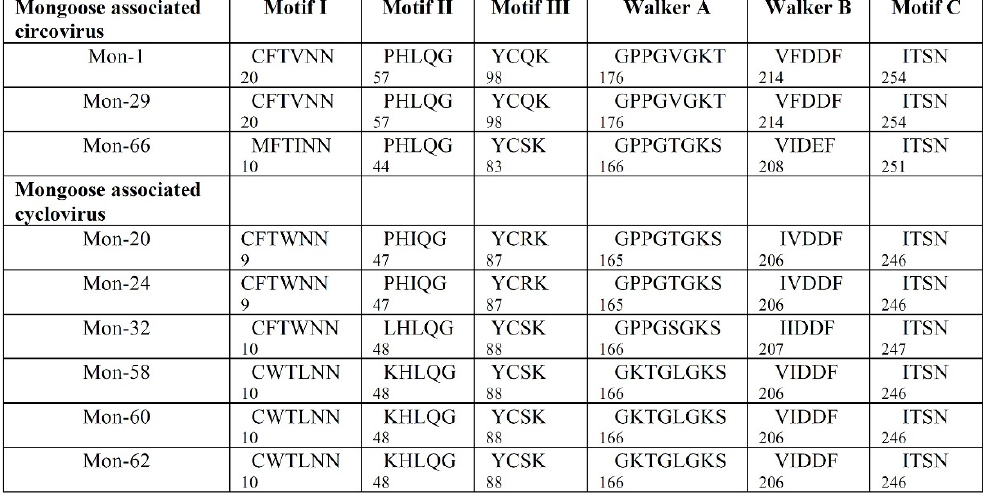
Figure 4. Presence of the conserved rolling circle replication (motifs I through III) and superfamily 3 helicase (Walker A and B, and motif C) motifs in the putative replication-associated proteins (Rep) of mongoose associated circovirus and cyclovirus. The number below the motif sequence indicates the position of the amino acid residue in the respective putative Rep